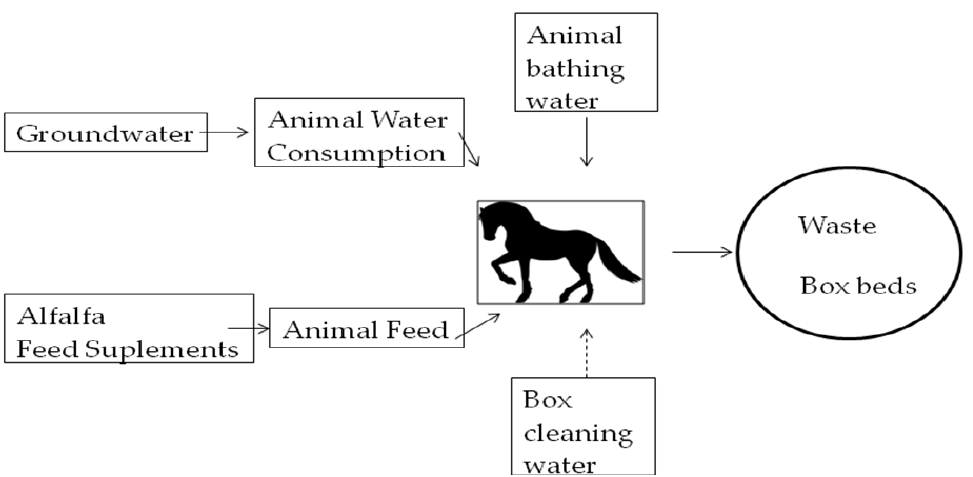
Figure 1. Diagram of water life cycle in this farm. Entire lines: use of direct water. Split lines: indirect use.